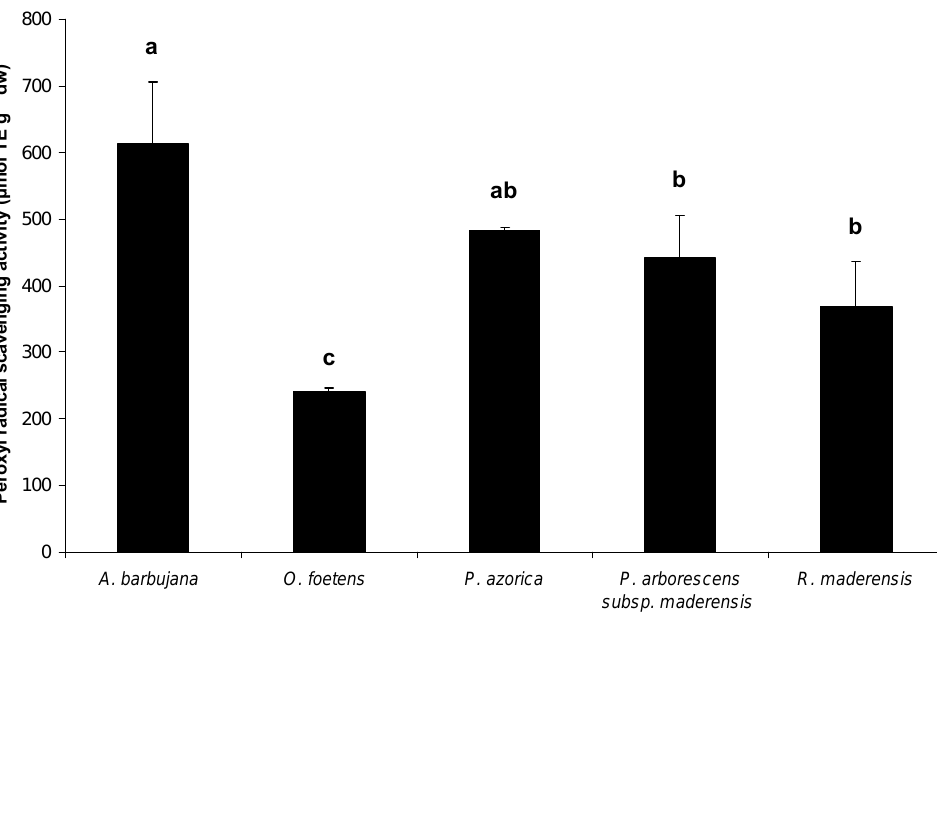
Figure 2. Peroxyl radical scavenging activity for the water:ethanol extracts of the five Macaronesia plants under study. Each point is the average of three independent replicates. Values are the mean of three independent replicates and bars represent SD. Superscript letters are the significance levels at p <